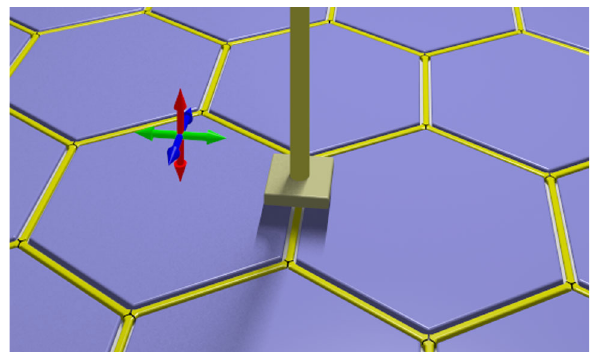
FIG. 1. Scanning defect microscopy of a photon lattice. A dielectric probe is scanned across a photon lattice of coplanar waveguide resonators. The dielectric locally perturbs the electric field and shifts the frequency of a target resonator, creating a lattice defect. The transmission of photons through the lattice systematically depends on the defect strength and can be used to image the photon occupancy on individual lattice